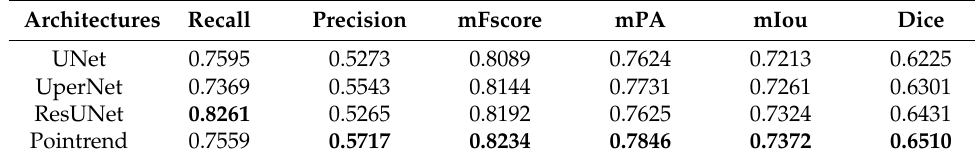
Table 1. Quantitative evaluations on the pavement crack dataset.